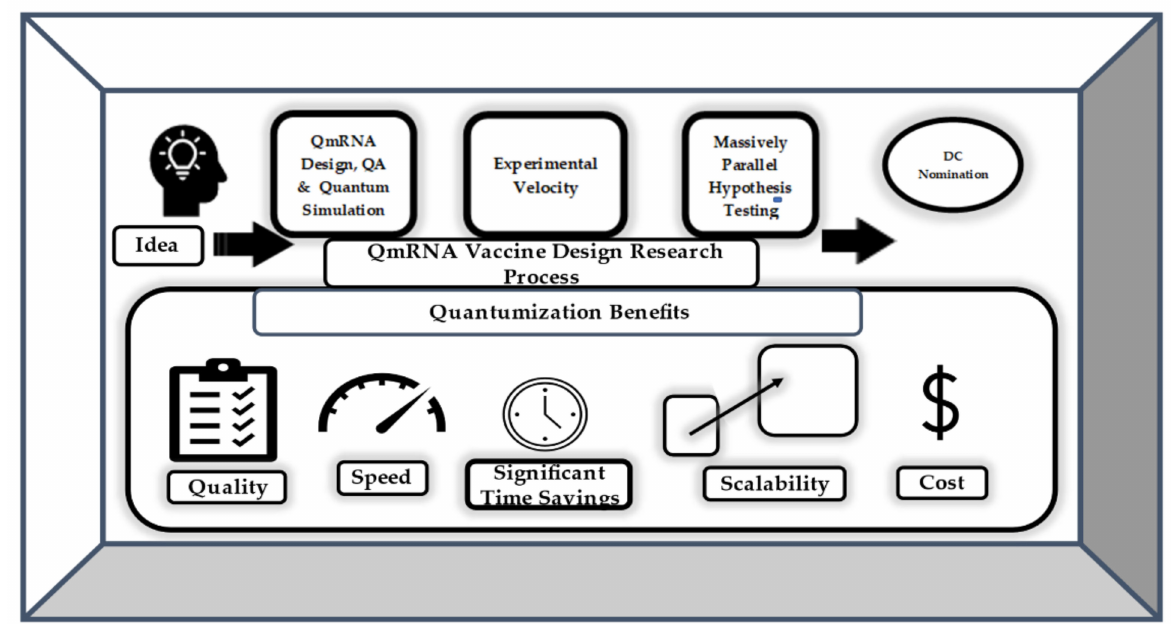
Figure 5. QmRNA vaccine design research